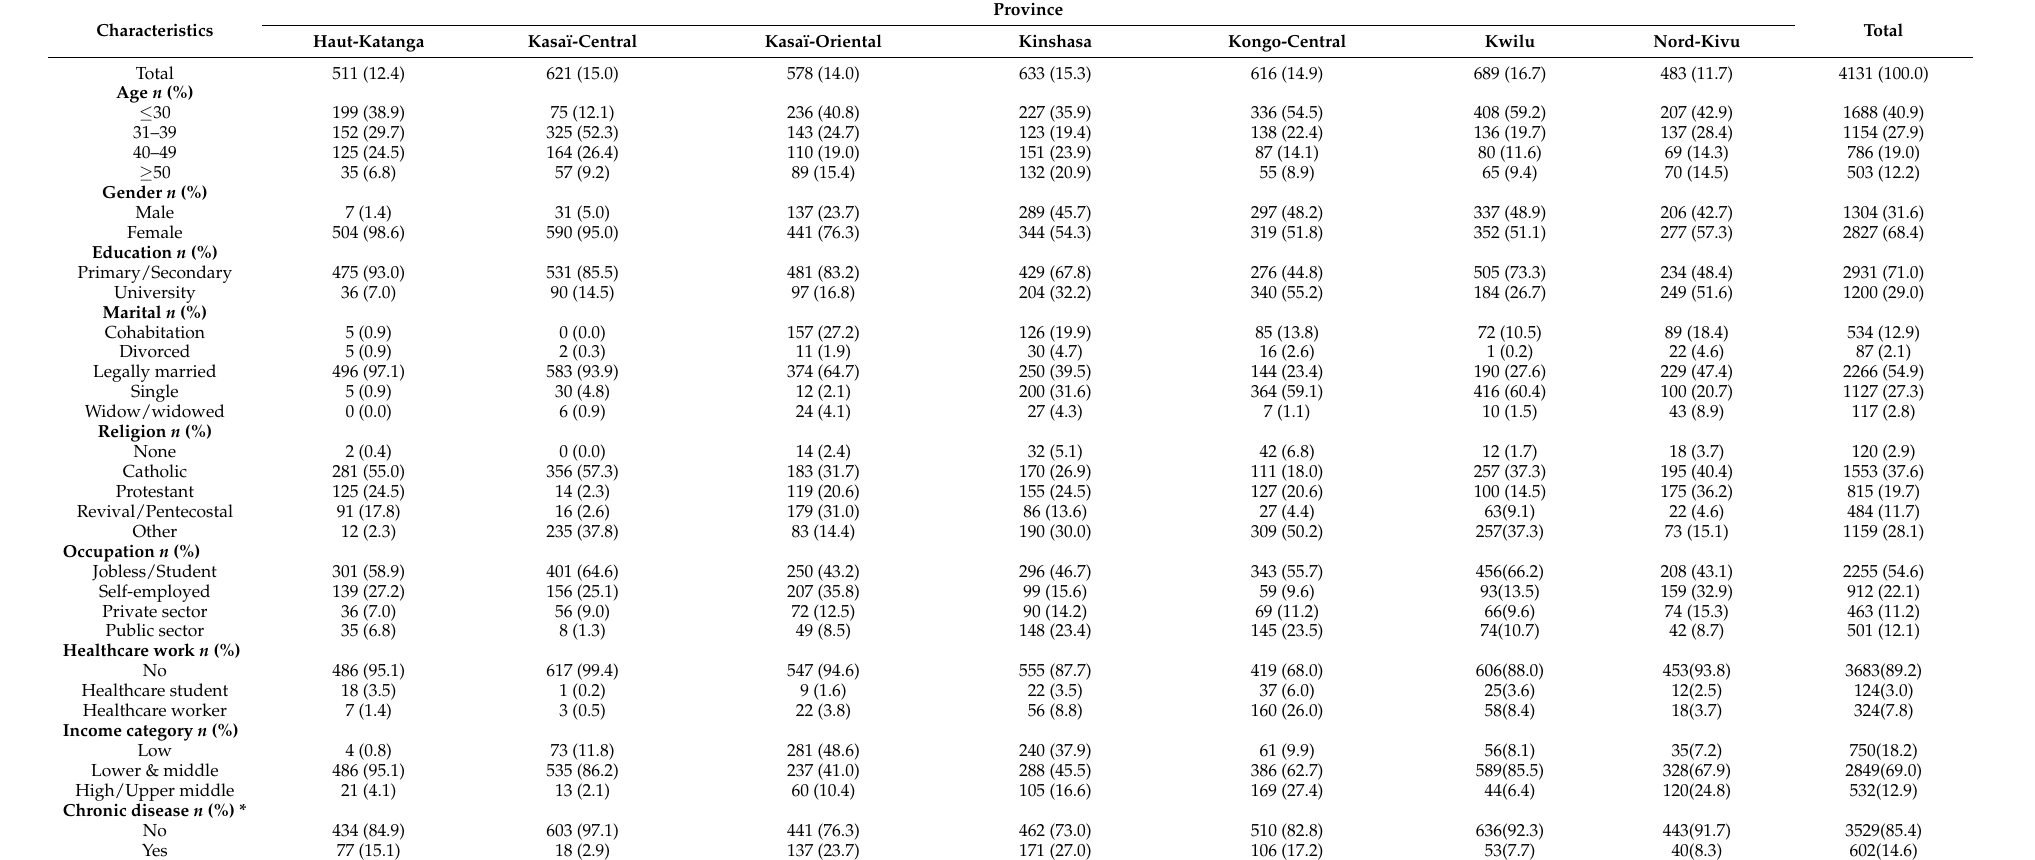
Table 1. Participants’ demographic characteristics per